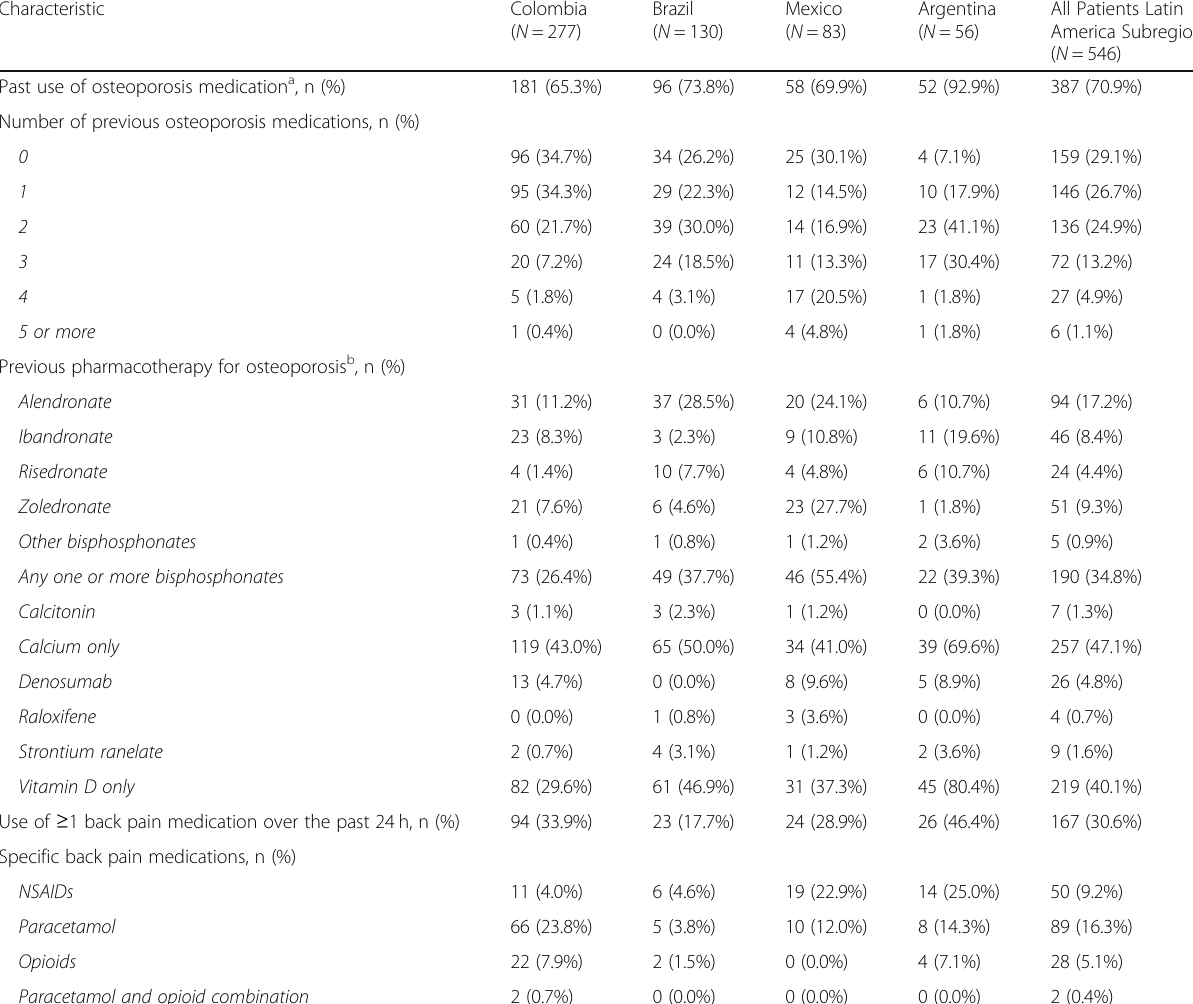
Table 3 Previous use of osteoporosis and analgesic medications